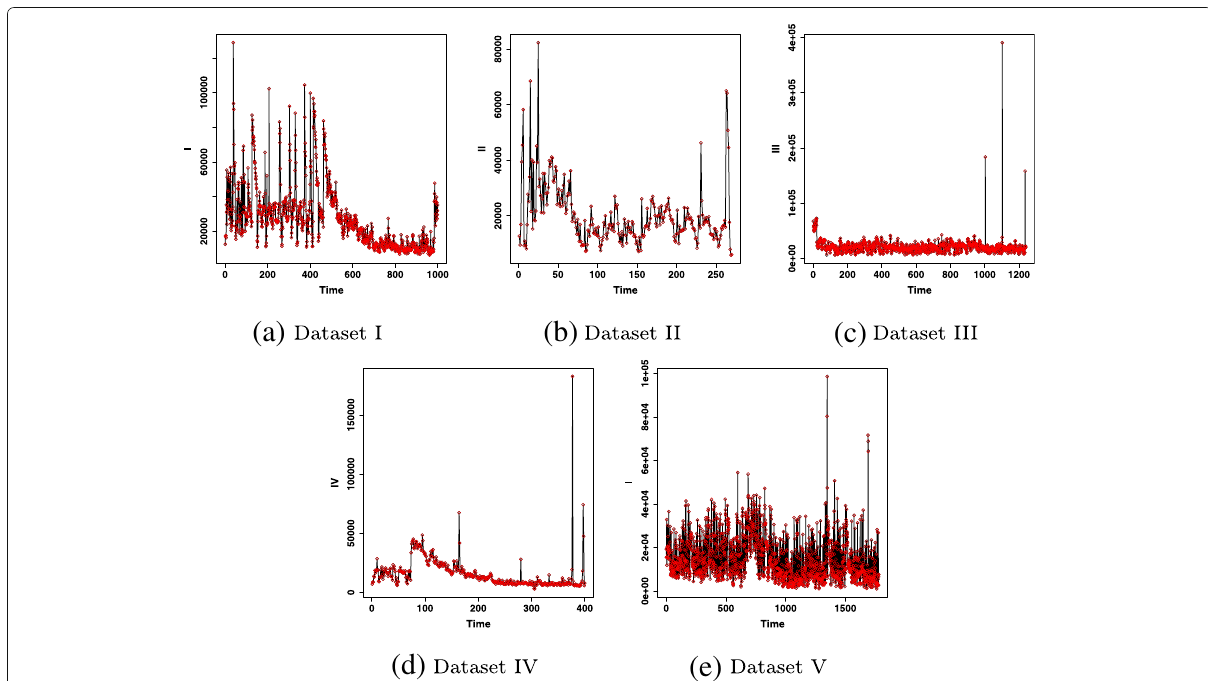
Fig. 4 BRNN-LSTM fitting results of cyber attack rates in the five datasets (black line: observed values; red circles: fitted values)